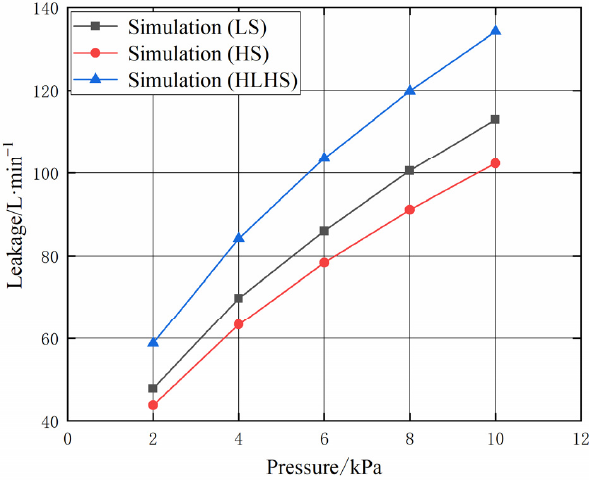
Figure 4. Leakage results of three types of seals (RE = 0 mm).